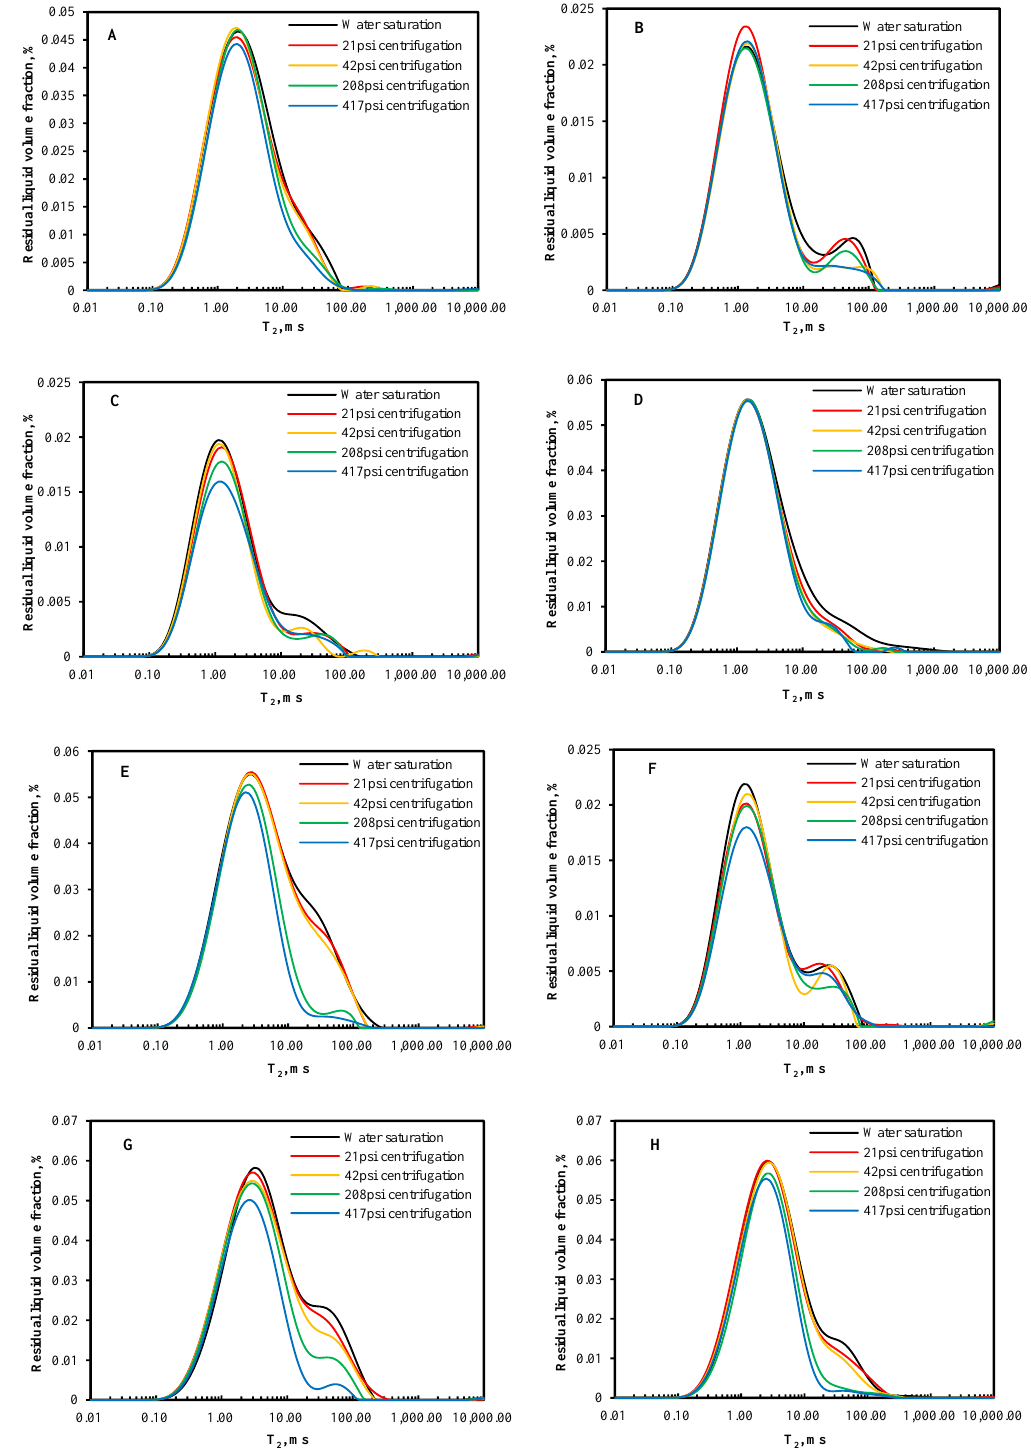
Figure 7. NMR results of movable fluid saturation analysis of samples from the Mahu area. ( A ) Well M604, 3896.4 m, conglomerate with small pebbles; ( B ) Well M604, 3919.1 m, pebbly sandstone; ( C ) Well M139, 3267.0 m, sandy conglomerate; ( D ) Well M139, 3277.7 m, conglomerate with medium pebbles; ( E ) Well M18, 3882.5 m, sandy conglomerate; ( F ) Well M604, 3929.5 m, fine-grained conglomerate; ( G ) Well M137, 3256.4 m, fine-grained conglomerate; ( H ) Well M137, 3249.8 m, conglomerate with small